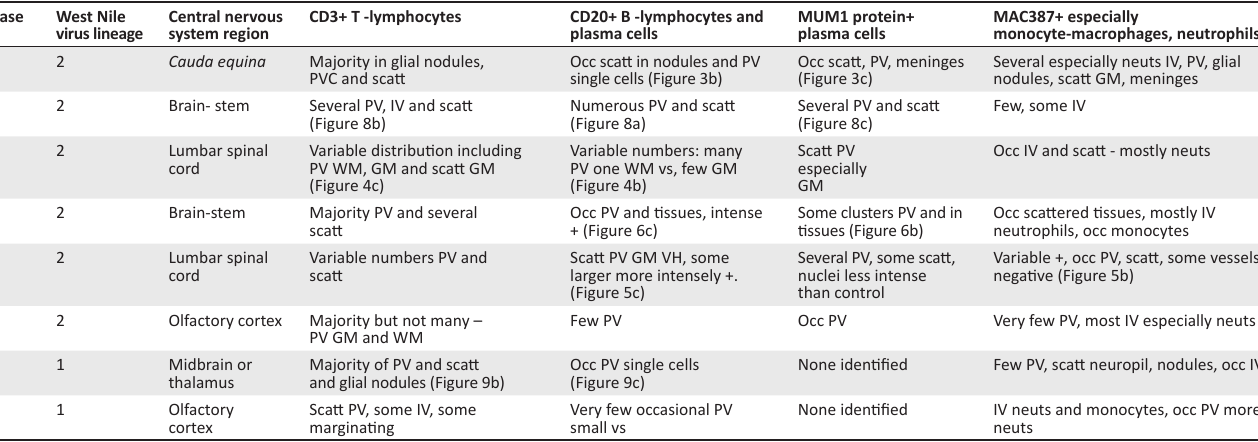
TABLE 3: Specific immunohistochemical labelling of inflammatory cells in areas of intense immunopathology in the central nervous system of West Nile virus-infected horses. Case West Nile virus